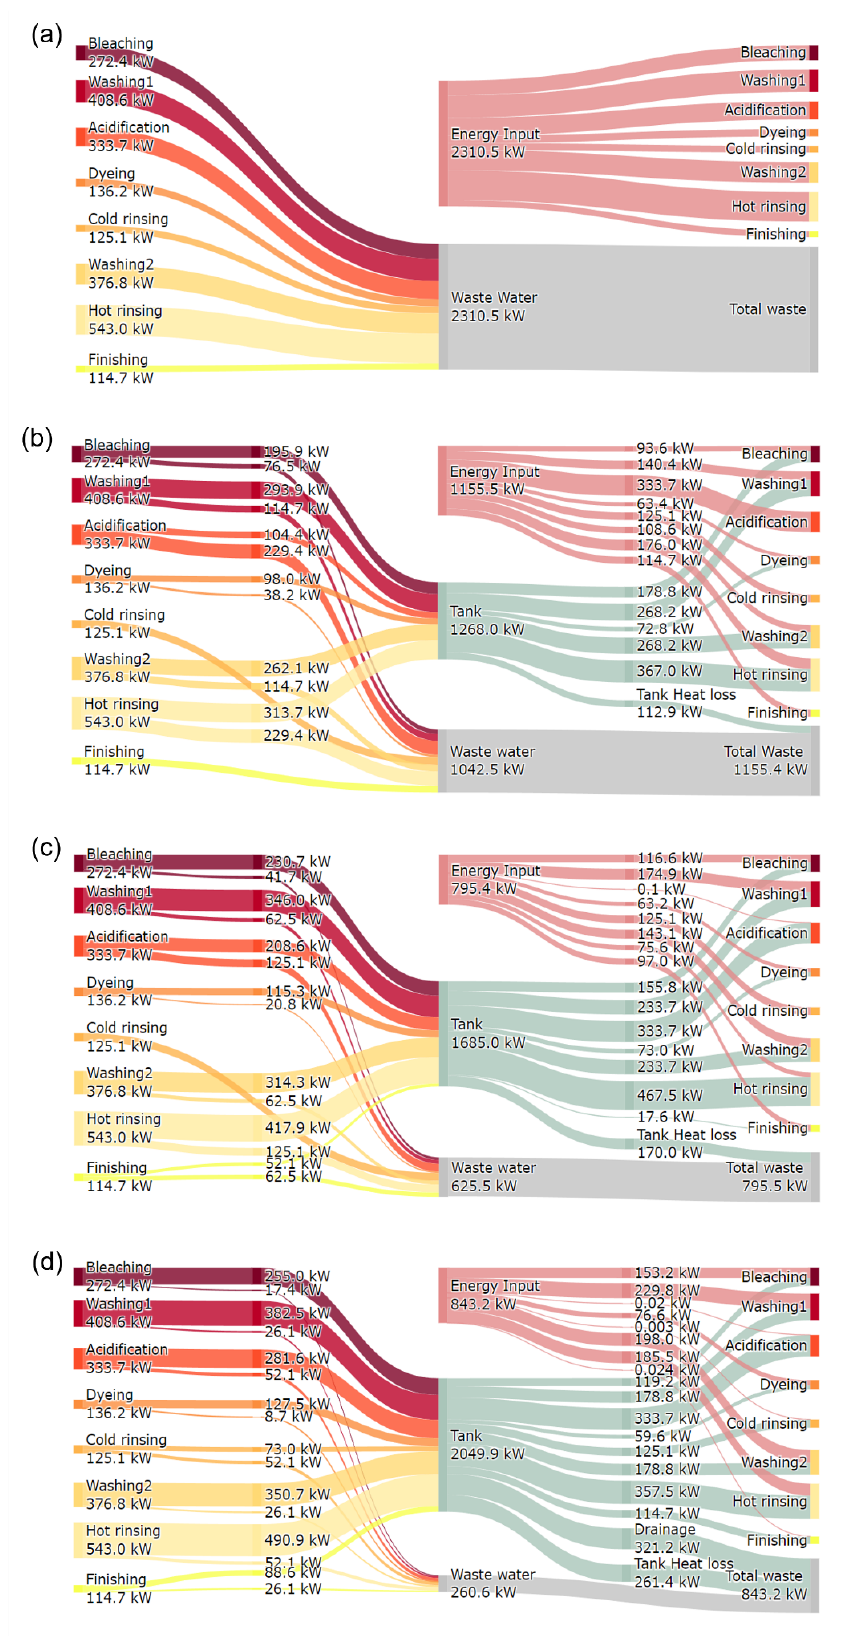
Figure 4. Energy flows in each case: ( a ) Base Case, ( b ) Case 1, ( c ) Case 2, and ( d ) Case 3.